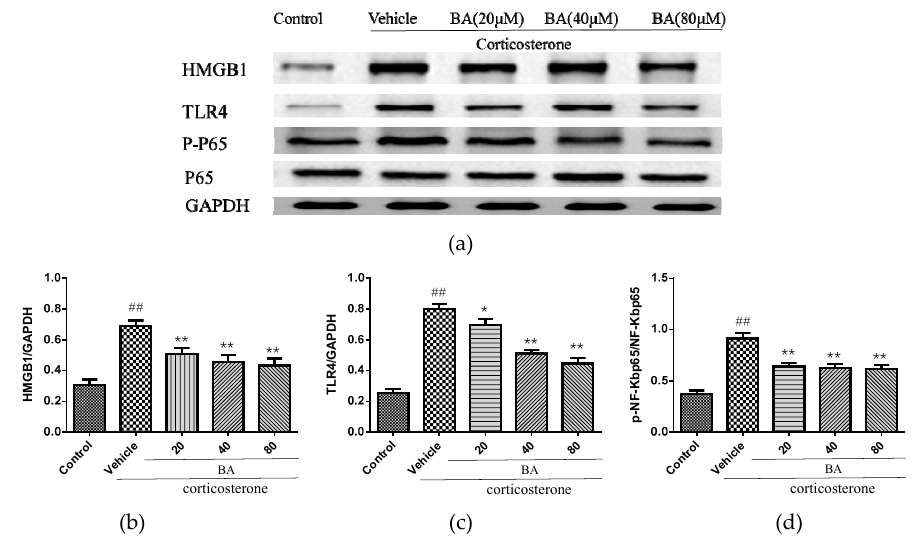
Figure 9. Effects of BA on ( a , b ) HMGB1/ ( a , c ) TLR4/ ( a , d ) NF- κ B signaling pathway in PC12 cells. Data were expressed as mean ± SEM ( n = 3). ## p < 0.01 vs. the control; * p < 0.05 and ** p < 0.01 vs. the corticosterone group.